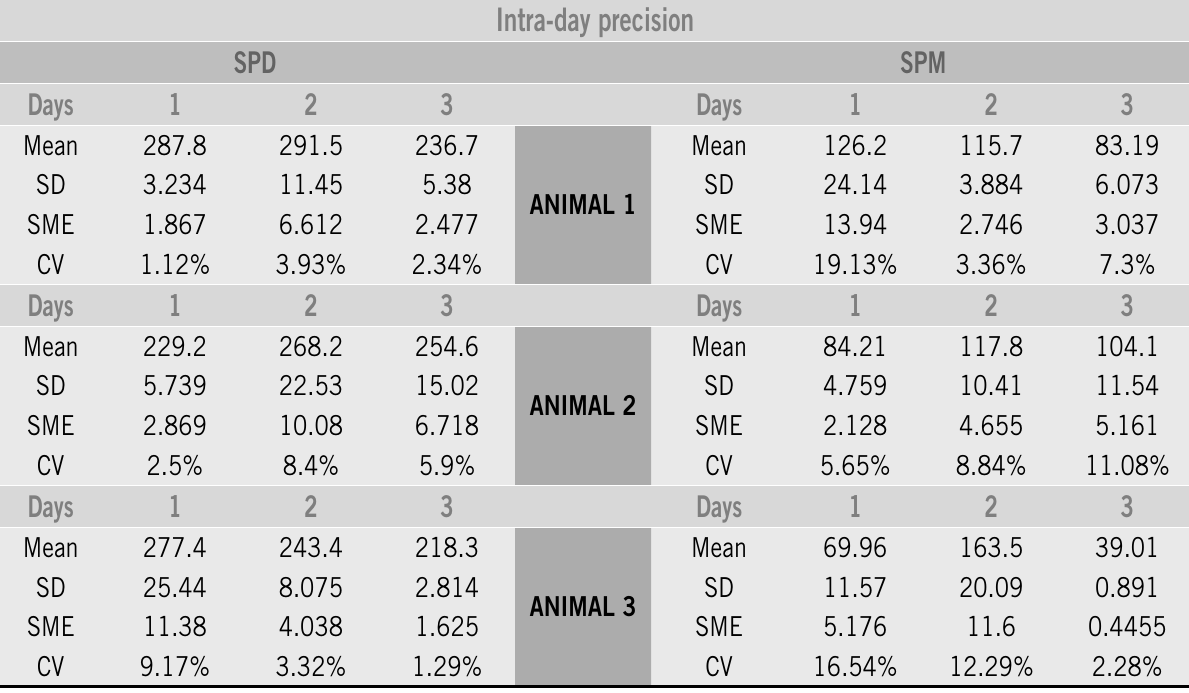
Precision calculation of 3 days ( n = 15) showing the average (picomoles), the Table 4 standard deviation (SD), the standard mean error (SME) and the coefficient of variation (CV) of the measures